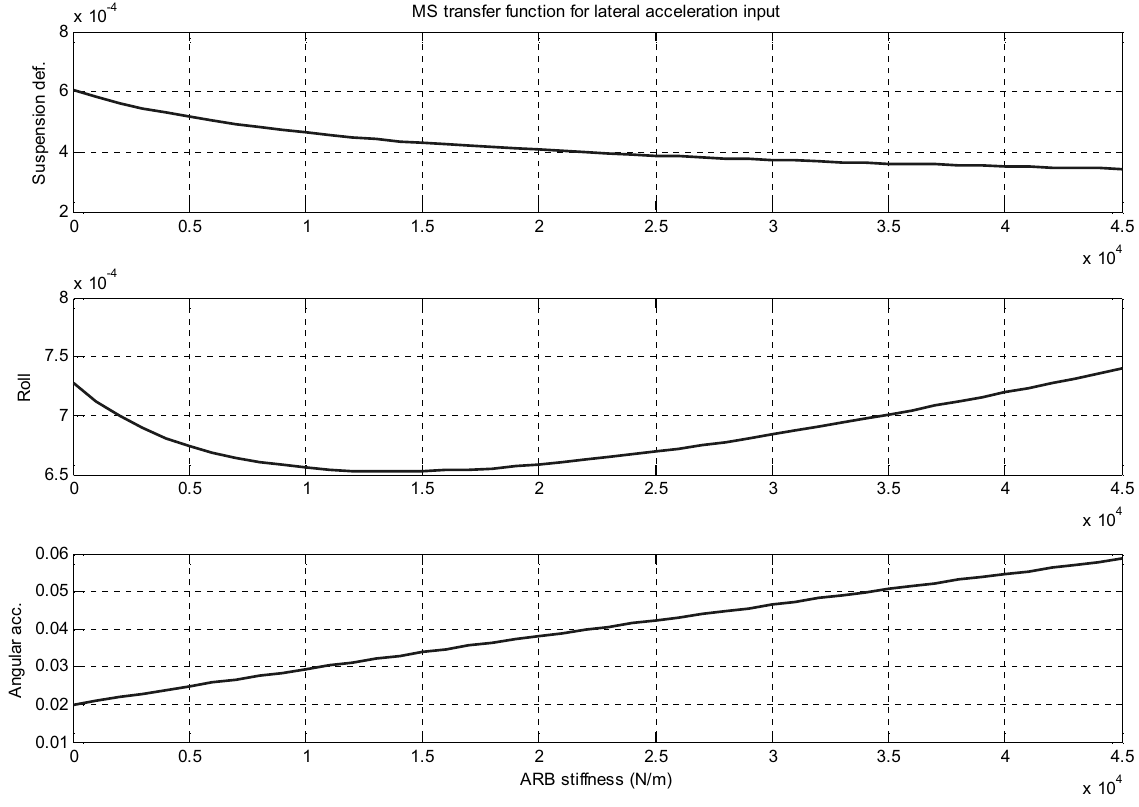
Fig. 4. RMS values of transfer function for acceleration